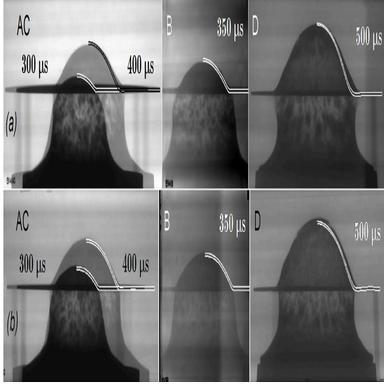
Experimental flash X-ray results and comparison with the calculations (shown as half plate black and white contours) for the as-received coarse silica sand loaded by the configuration U charge, ρ0 = 1.54 g/cm3 (a) and configuration V charge, ρ0 = 1.44 g/cm3 (b).